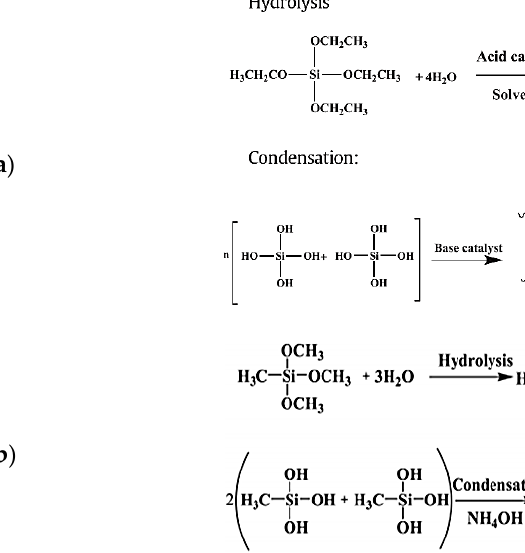
Figure 2. Common precursors for silica aerogels applied in CO 2 capture. The sol-gel processes for hydrophilic (TEOS) and hydrophobic (MTMS) silica aerogels as a result of the hydrolysis and condensation mechanism are shown in Scheme 1a [22] and Scheme 1b [23], respectively.